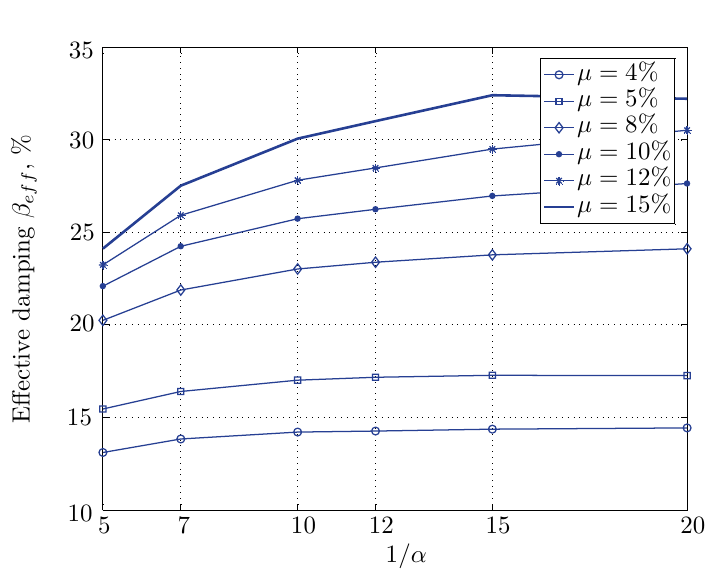
Figure 24. Effective damping for various isolation system parameters (Lexington